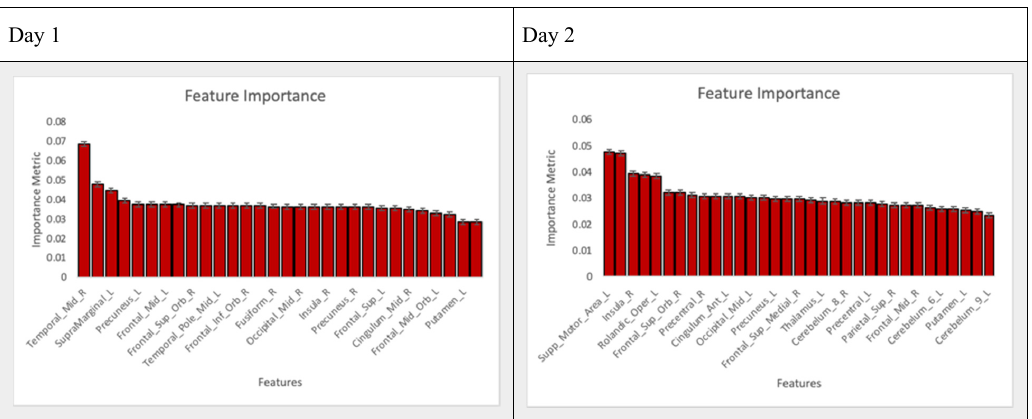
13 of 20 Legend: Figure 3. AAL regions selected across Bucket of Models and plotted on the brain for qualitative evaluation. Each of these AAL regions was selected by one or both of the respective Day 1 or Day 2 models based on the training set and validated to achieve the importance metric on the testing set.